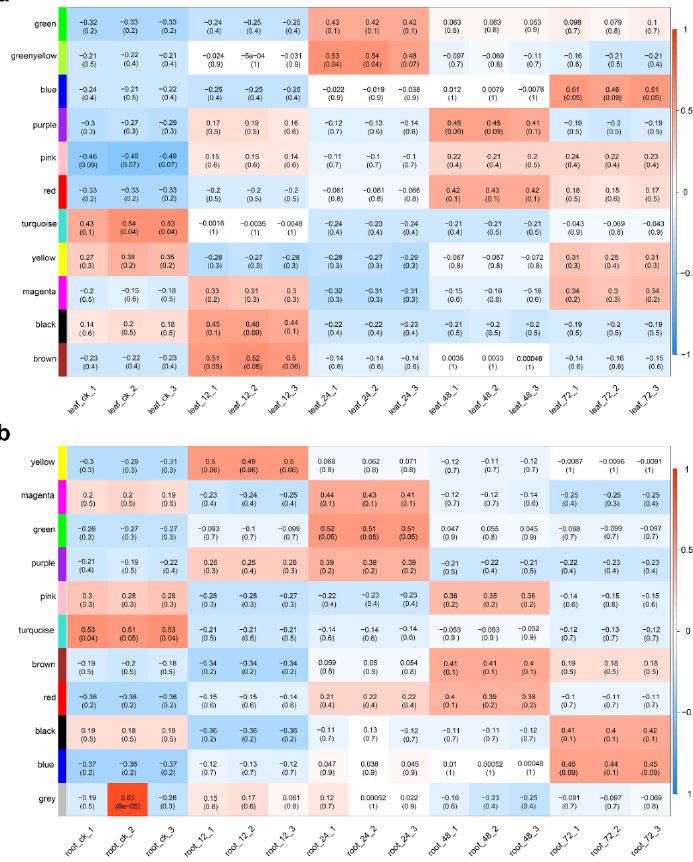
Figure 4. Correlation between modules and each sample in co-expression networks in leaves ( a ) and roots ( b ). Each row represents a module eigengene, and each column a sample. Each cell contains the corresponding correlation and p -value.